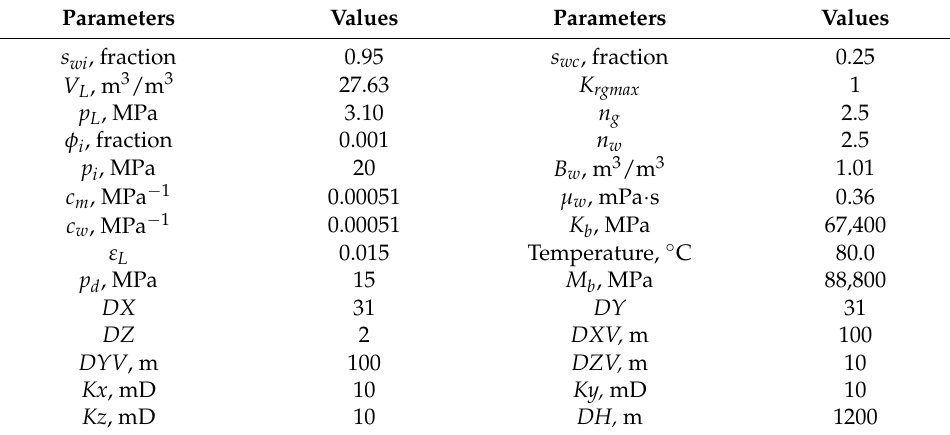
Table 1. The parameters used in the numerical